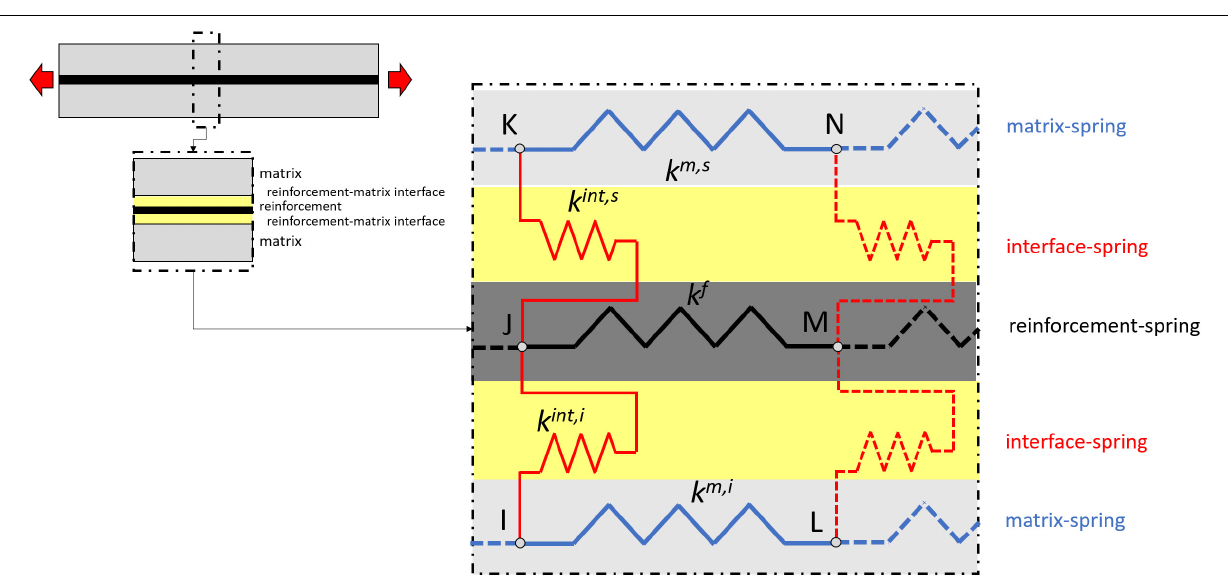
FIGURE 3 | Spring-model for the study of the tensile behavior of FRCM specimens (Grande and Milani,